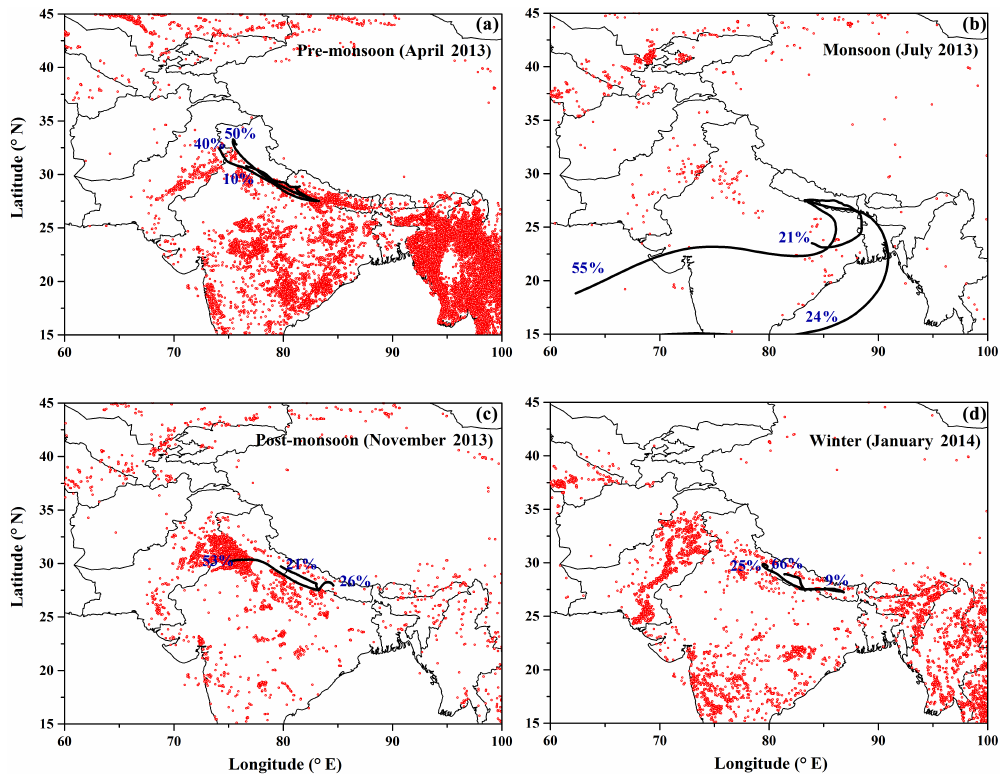
Figure 9. Spatial distributions of fire spots observed by MODIS and air-mass trajectories of Lumbini, northern IGP, shown by clusters of 5-day backward trajectories arriving at 500m above ground level during April 2013–March 2014. The numbers in each panel indicate the percentages of daily trajectories with the origins.